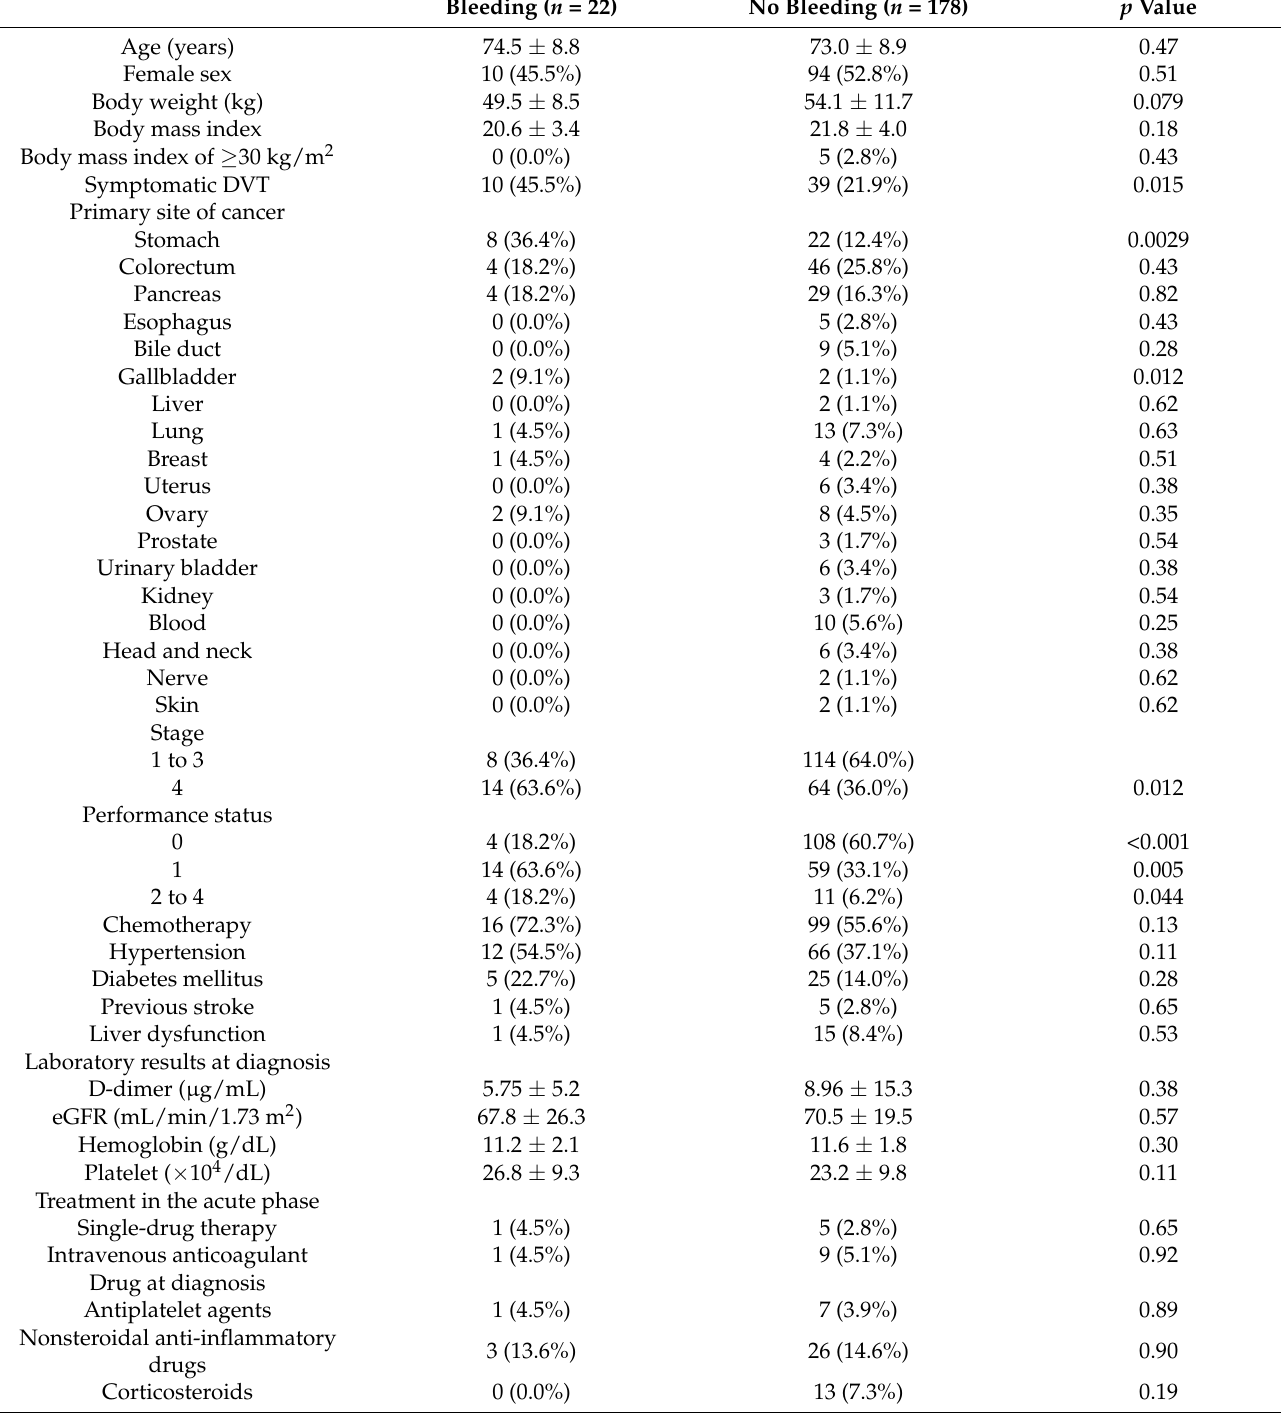
Table 2. Comparison between patients with bleeding and without